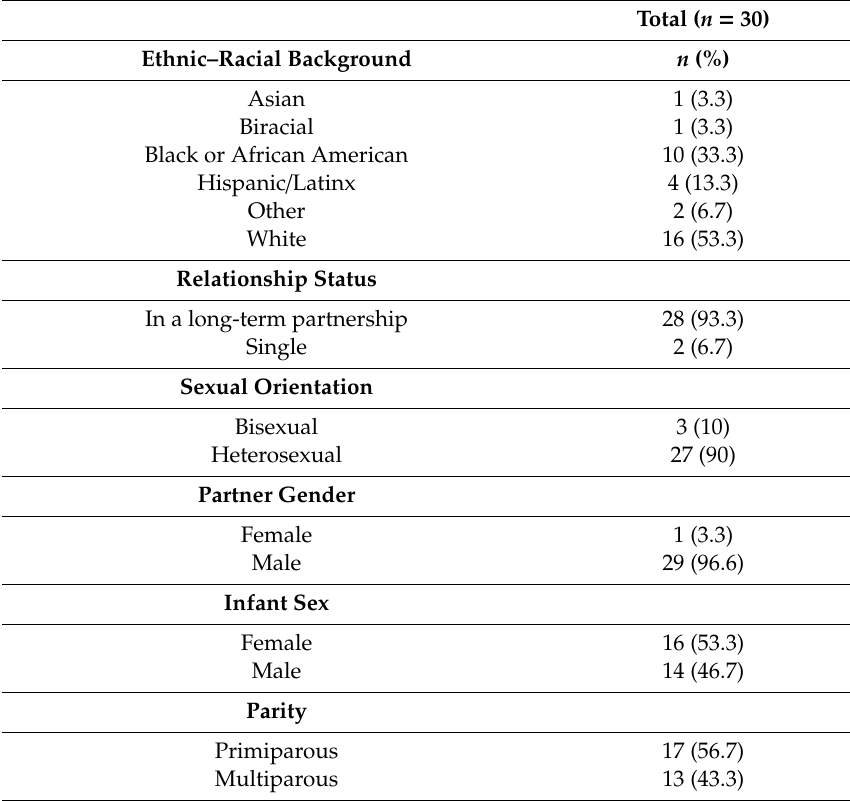
Table 1. Participant sociodemographics and scores for self-report